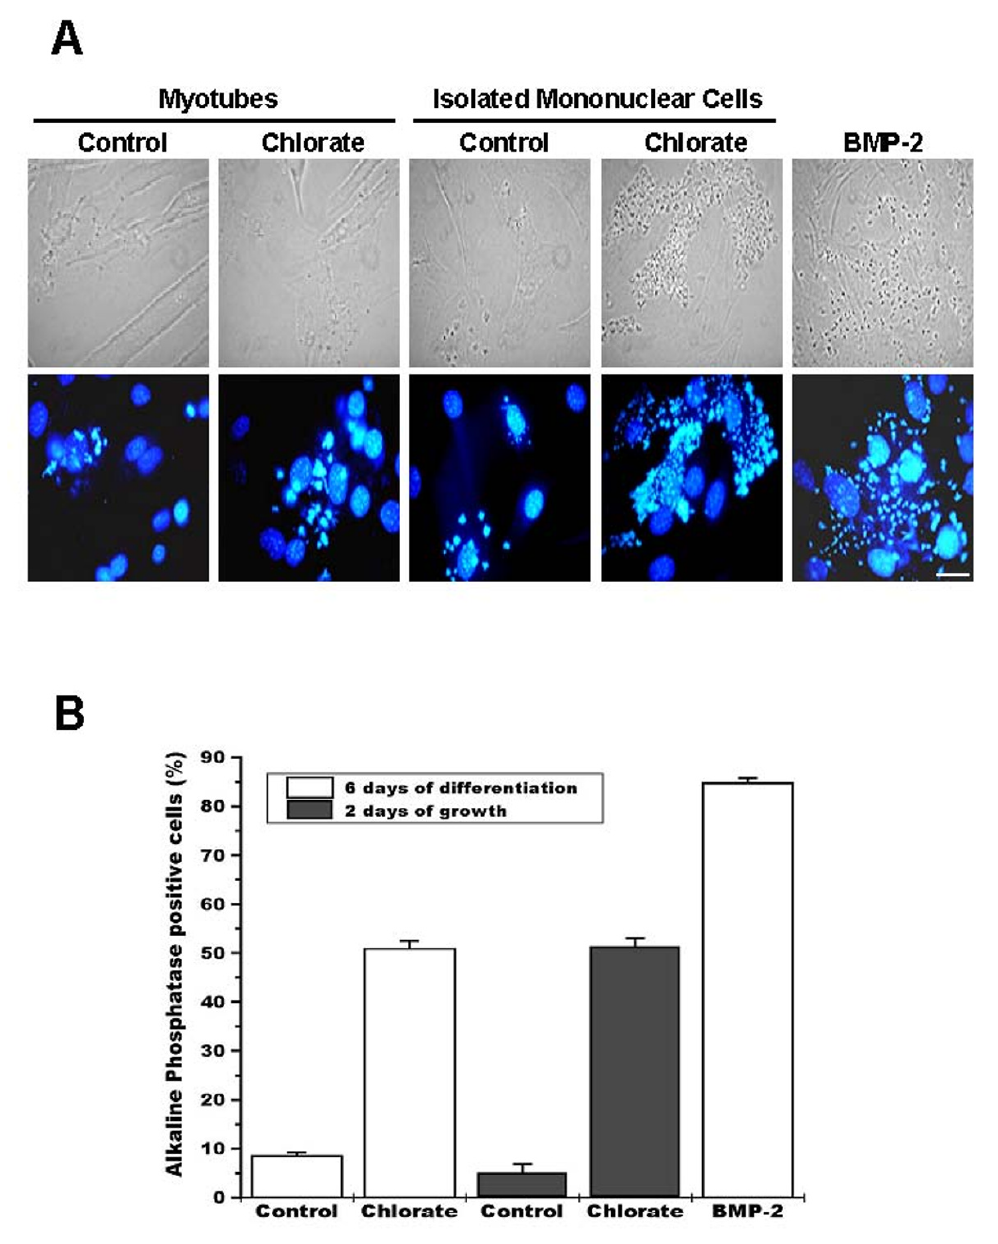
Figure 2 Under conditions of proteoglycan sulfation inhibition, alkaline phosphatase activity is present in mononuclear skeletal muscle cells . A . C2C12 cells were induced to differentiate for 6 days in the absence (first column) or presence of 30 mM sodium chlorate (second column). Remaining mononuclear cells from control (third column) or sodium chlorate treated cultures (fourth column) were isolated and grown for 48 hours. C2C12 cells induced to differentiate in the presence of 5 nM BMP-2 were used as positive control (fifth column). Unpermeabilized cells were fixed and alkaline phosphatase activity was visualized as a fluorescent precipitate using ELF-97 detection kit; nuclear staining was performed with 1 μ g/ml Hoechst 33258 (lower row). Phase contrast microscopy is shown in the upper row. Bar = 25 μ m. B . Percentage of ALP-positive mono- nuclear cells in the different experimental conditions described in A. Values correspond to mean ± S.E.M. of 10 different micro- scopy fields from two independent experiments. ANOVA analysis followed by Tukey-Kramer multiple comparisons test shows there are no statistically significant differences when both control or both chlorate conditions (p > 0.05) are compared. All other comparisons are significantly different (p <